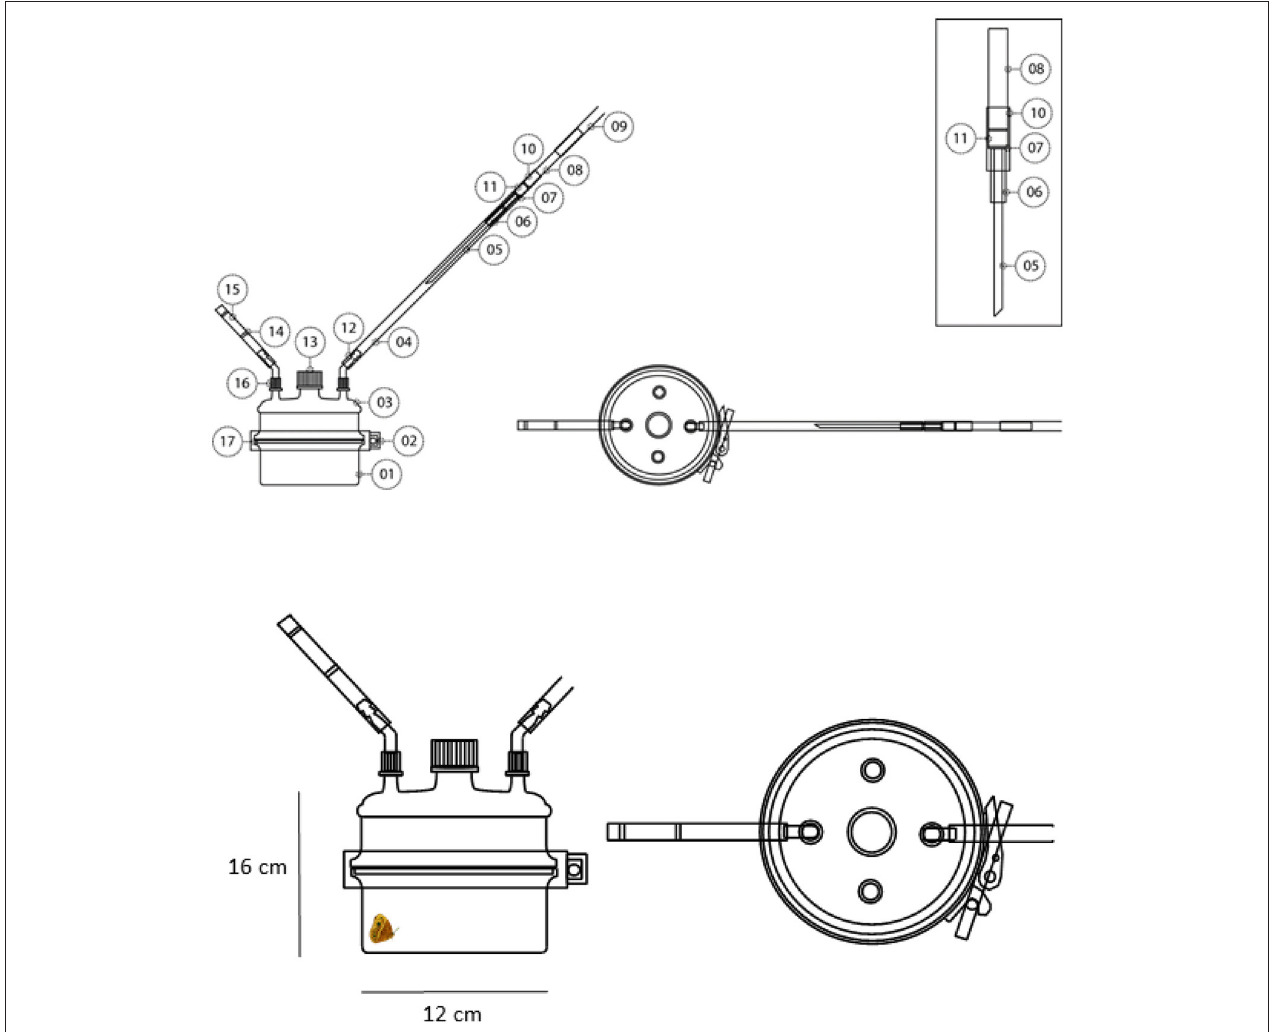
FIGURE 2 | Top: headspace entrainment area. Left: side view (with two smaller ports omitted from the lid). Right: viewed from above showing all ports. Labels: 01, culture flask injection head; 02, stainless steel band; 03, corresponding culture flask lid with added ports; 04, 8mm PTFE tubing; 05, 3mm glass with 45 degree cut; 06, 5.5mm outer diameter PTFE; 07, 7mm outer diameter PTFE; 08, 7mm outer diameter glass; 08, 8mm PTFE tubing; 10, metal grid; 11, Tenax-TA 20/35; 12, silicone rubber sealed plastic hose connector; 13, GL45 centralized screwthread with cap; 14, glass wool plug; 15, activated dry carbon; 16, GL14 screwthread and cap with aperture; 17, PTFE “O” ring. Inset: magnified annotated sorbent cartridge design. Bottom: magnified view from side and